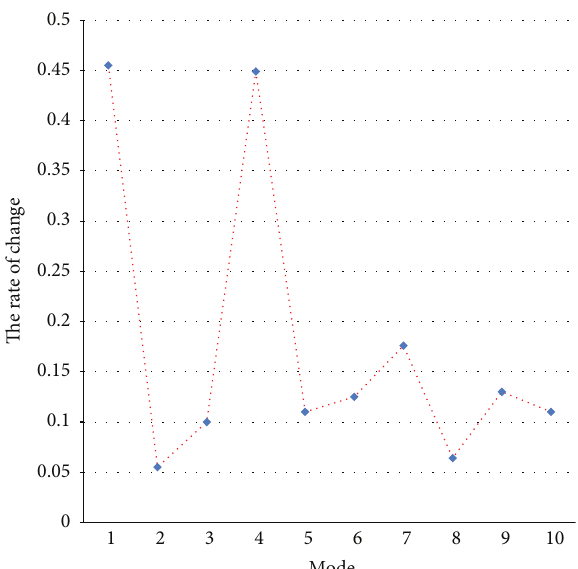
Figure 6: The change rate of the natural frequency.